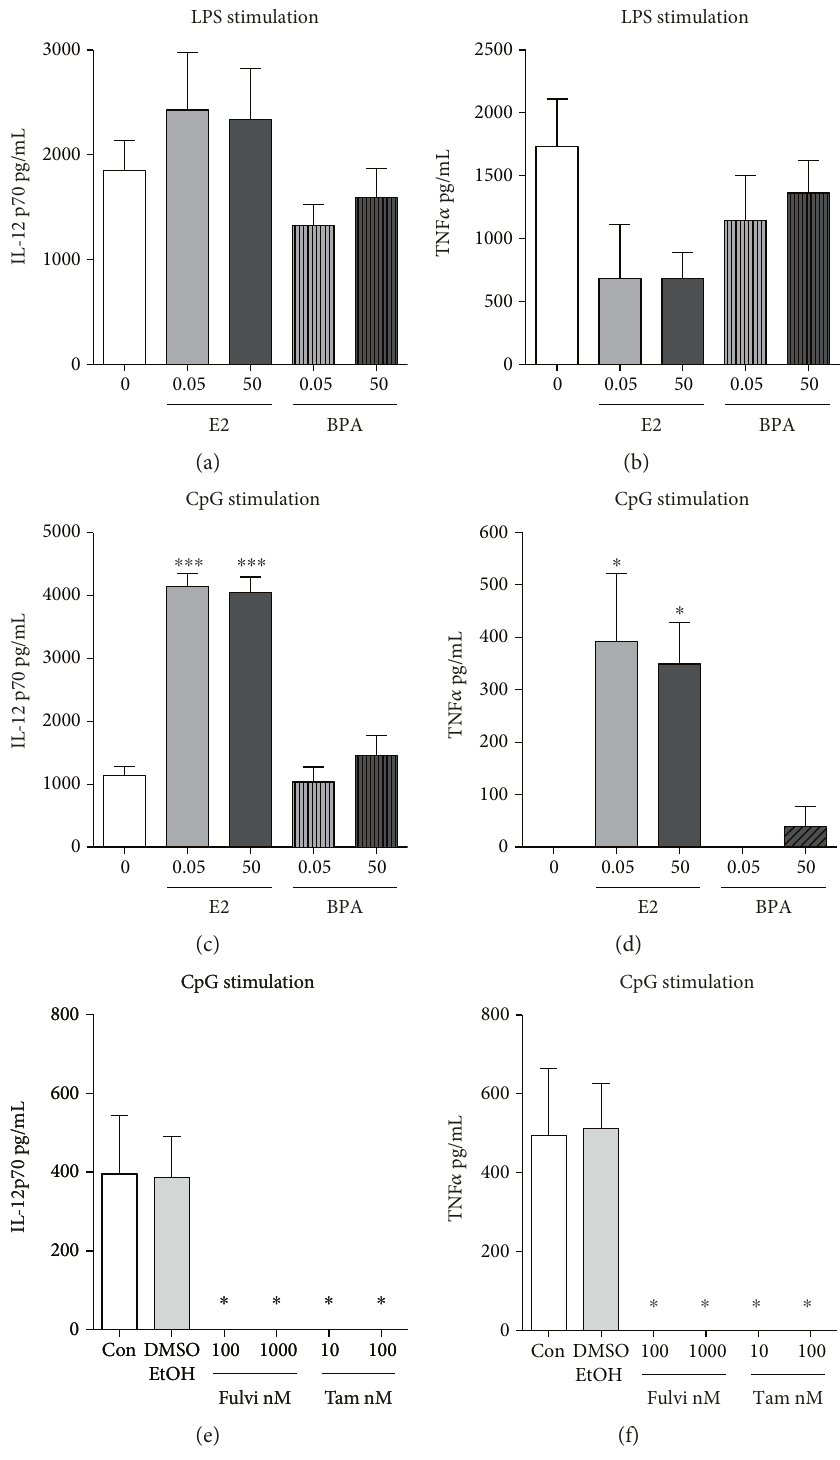
Figure 3: Estrogen but not BPA regulates the production of proin fl ammatory cytokines by cDCs upon TLR stimulation. We grew cDCs in the absence or presence of low (0.05 nM) and high doses (50 nM) of E2 or BPA for 6-7 days (a – d) or in regular medium in the presence or absence of SERMs fulvestrant or tamoxifen (e-f). We then stimulated cDCs with either 100ng/mL of LPS (a-b) or 10 μ g/mL of CpG (c – f) and measured IL-12p70 and TNF α levels by ELISA in DC culture supernatants 24 hours post stimulation. Results are the averages and SE of four DC cultures (a-b, c-d) and two DC cultures with two biological duplicates each (e-f). Statistical signi fi cance was calculated by one- way ANOVA and post hoc multiple comparison test against 0 condition (no E2 nor BPA) or control. DMSO and EtOH were used as vehicle controls. ∗ represents p < 0 05 , ∗∗ for p < 0 01 , and ∗∗∗ for p < 0 001